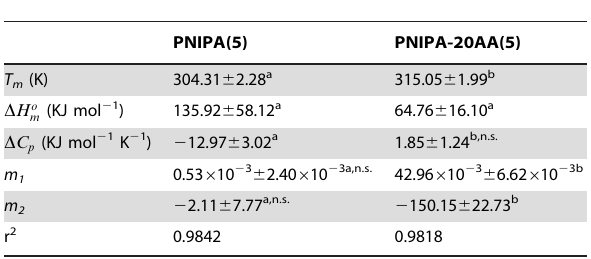
Table 4. Parameters generated from fitting the Equation 19 to experimental data of optical density variation in PNIPA/AA nanohydrogel suspensions as a function of temperature (T, K) and